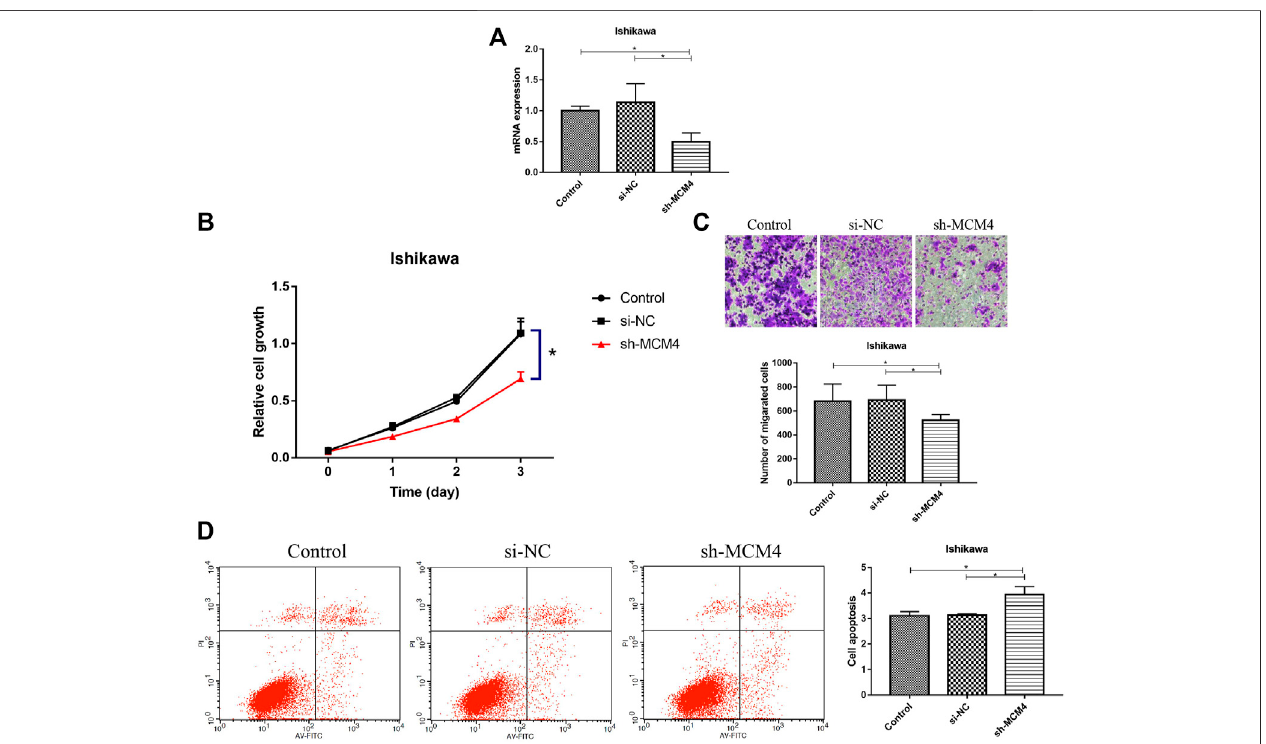
FIGURE 8 | Knockdown of MCM4 inhibit cell proliferation, migration, and promotes apoptosis of Ishikawa cells. (A) MCM4 knockdown ef fi ciency in Ishikawa cell lineswereexaminedbyqRT-PCR. (B) EffectsofMCM4silencingonproliferationofIshikawacellsweremonitoredbytheCCK-8assay. (C) EffectsofMCM4silencingon invasion ofIshikawa cells were detected bythe Transwellassay. (D) The apoptosis of Ishikawa cells after MCM4 knockdownwasdetected by fl ow cytometry. *: p -value < 0.05. qRT-PCR, quantitative real-time polymerase chain reaction. CCK-8, cell counting kit-8.